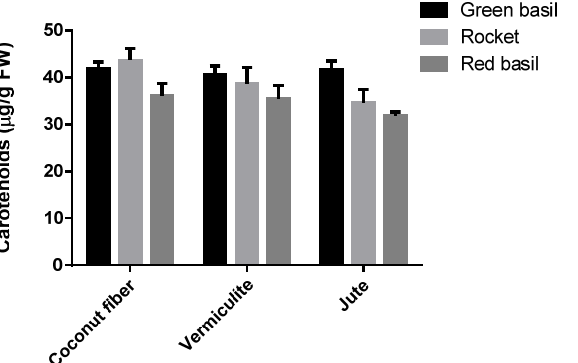
This species showed high concentrations of chlorophyll a + b .